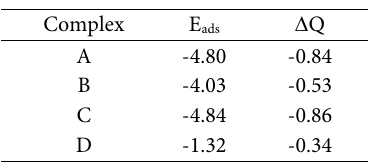
Table 2. Adsorption energies (in eV) and charge transfers based on Mulliken charges (in |e|) for IMMUCILLIN-A drug adsorbed on the considered TiO anatase 2